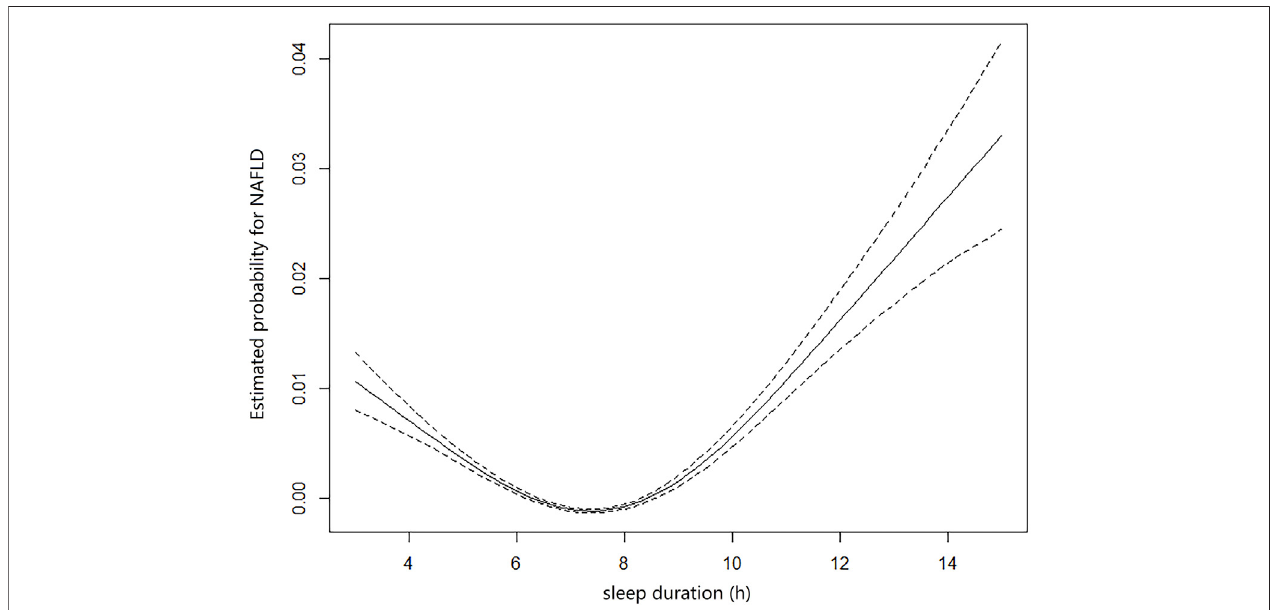
FIGURE 2 | General additive model plotting the U-shaped association between self-reported sleep duration and probabilities of prevalent NAFLD (sleep duration < 3 h and > 15 h were excluded).